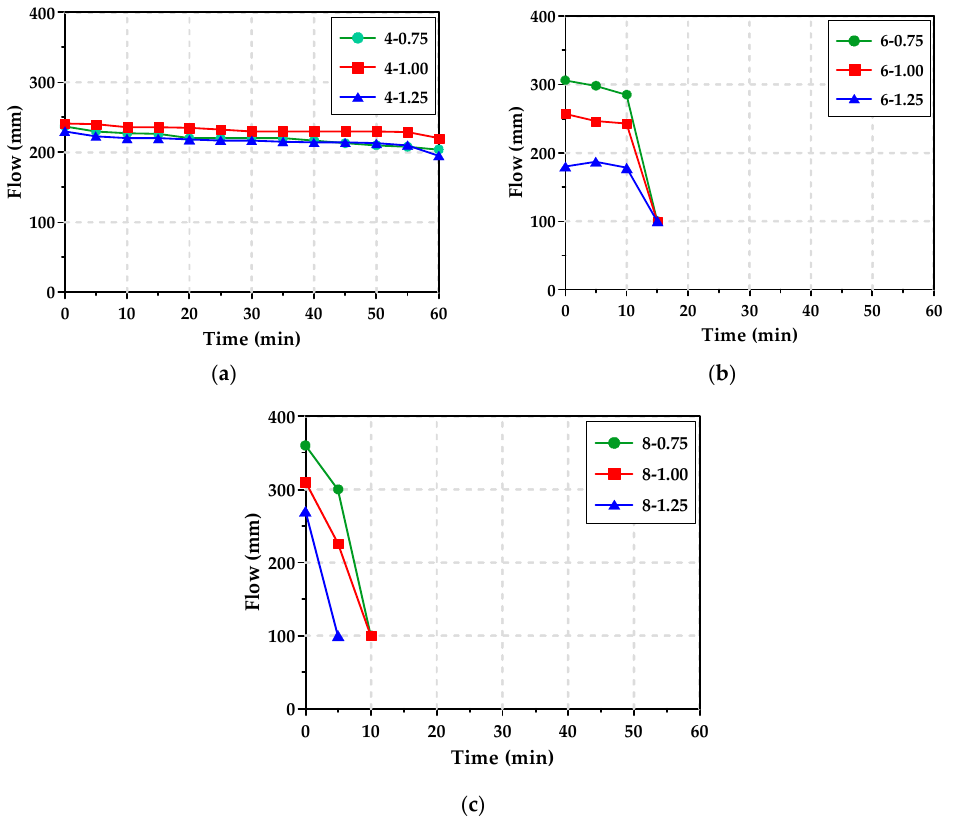
Figure 5. Mini slump curves of AAS pastes: ( a ) Na 2 O content = 4%, ( b ) Na 2 O content = 6%, ( c ) Na 2 O content = 8%.